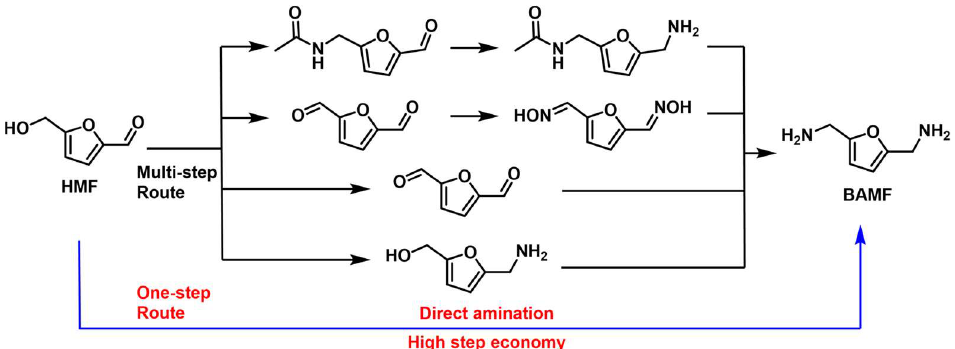
Figure 12. Catalytic synthesis of BAMF from HMF. Adapted with permission from ref. [128]. Copy- right 2011 RSC